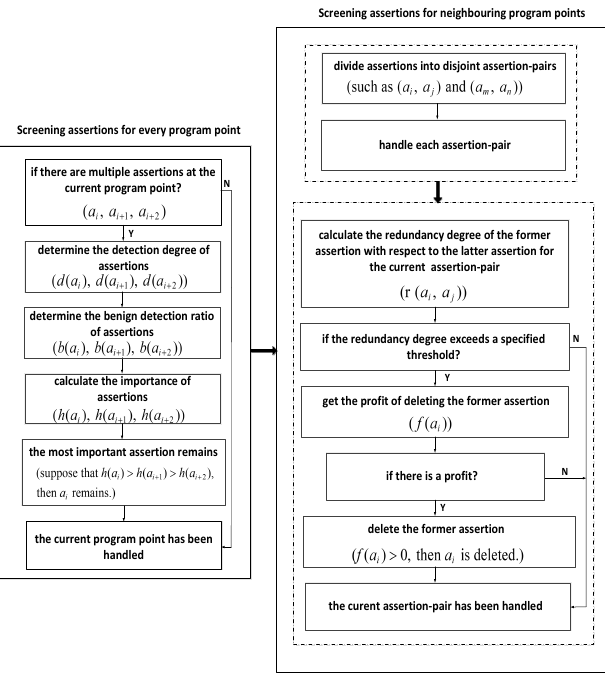
Figure 2. The overview of the F_Radish